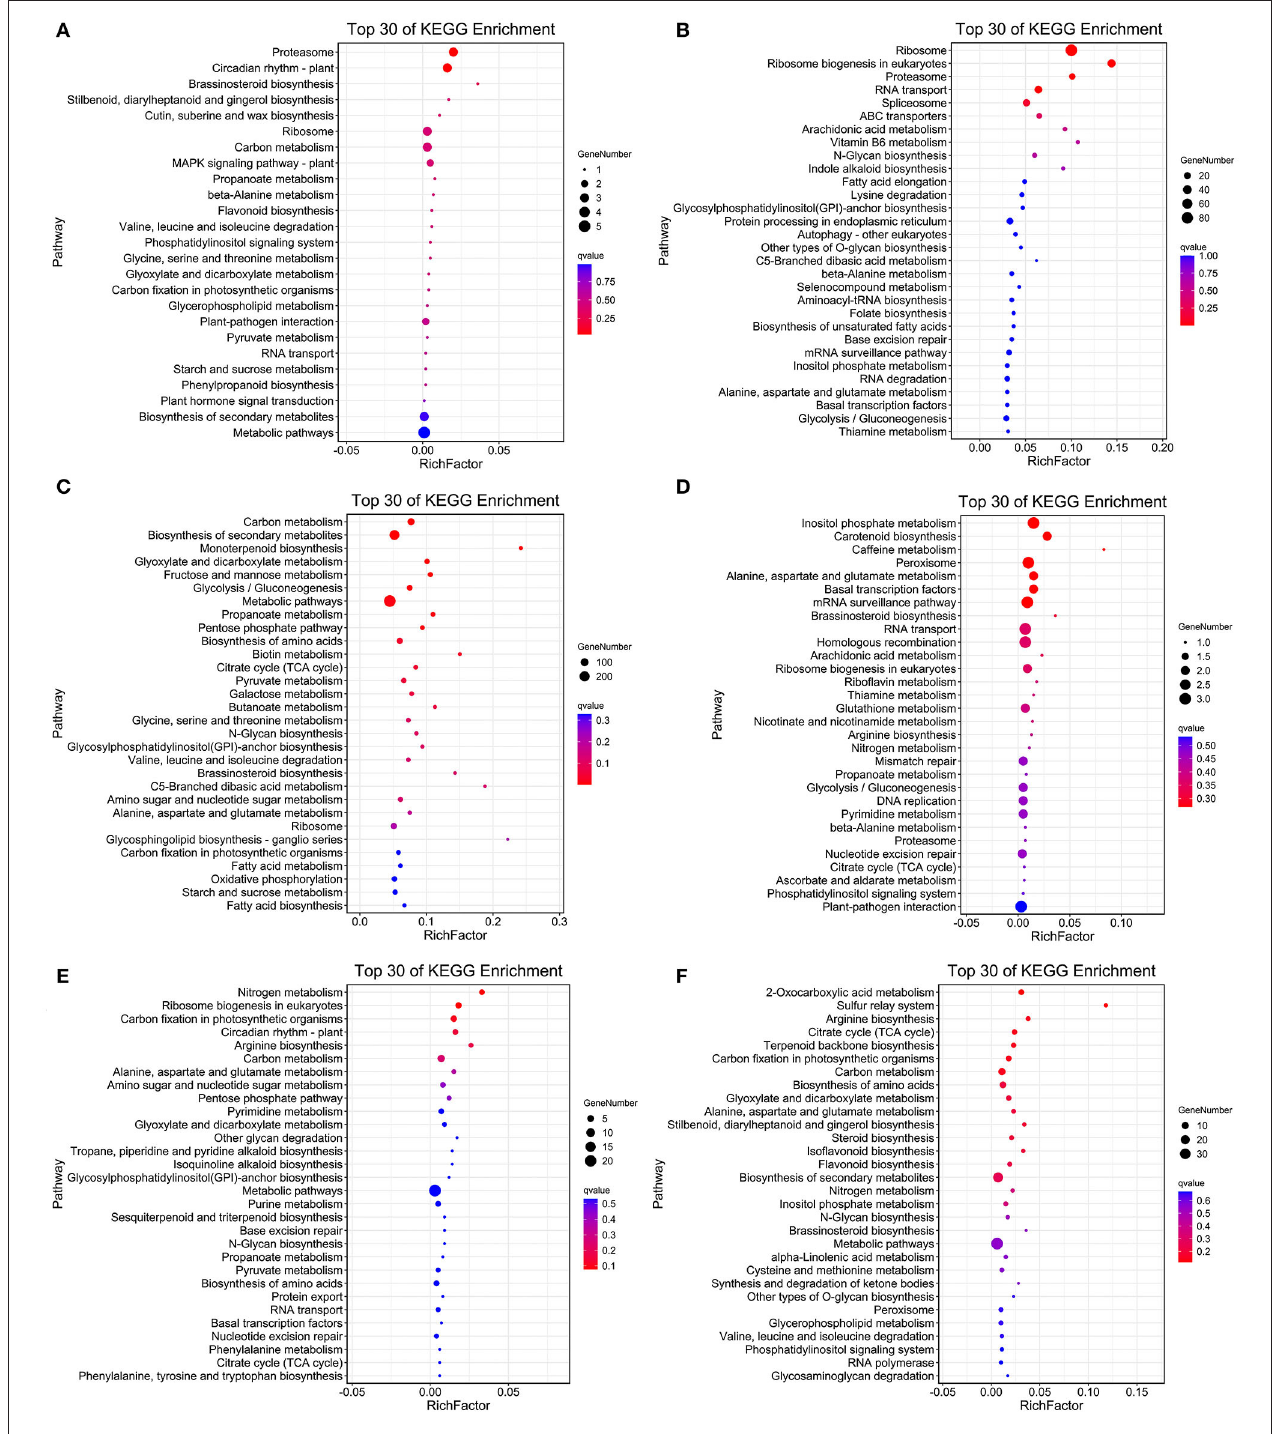
FIGURE 4 | Top 30 of KEGG enrichment genes of uniquely upregulated DEGs in R and S at T1 (A,B) , T2 (C,D) , and T3 (E,F) .